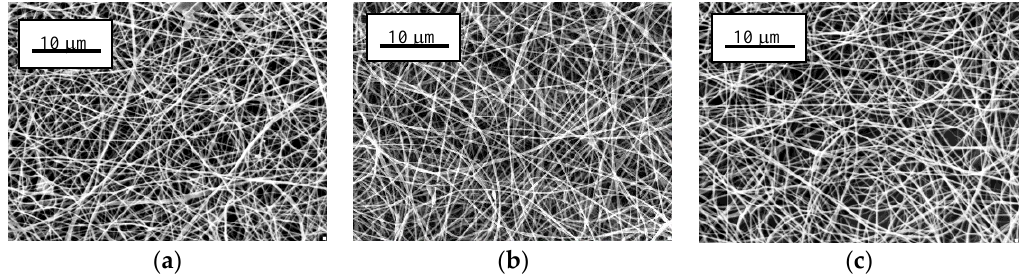
Figure 11. Typical SEM images showing three nanofiber bridges between the two walls of V-shaped substrate (variation D): ( a ) bottom bridge, ( b ) middle bridge, and ( c ) top bridge.